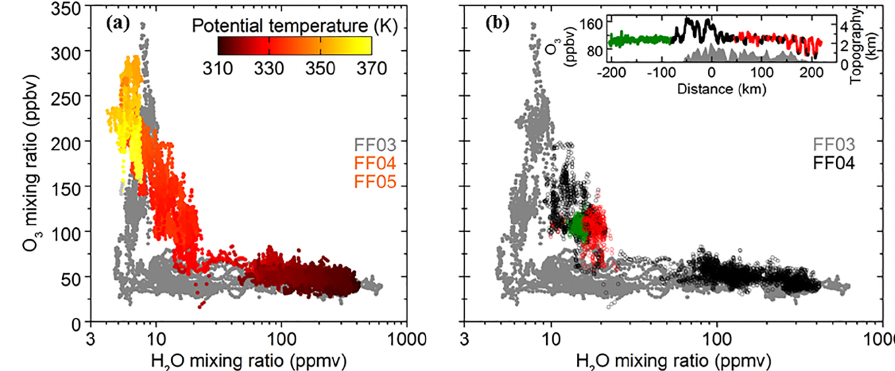
Figure 8. H 2 O–O 3 correlation for three Falcon flights: (a) FF04 and FF05 in mountain wave conditions and FF03 in unperturbed conditions. Potential temperature is color-coded for FF04 and FF05. (b) FF04 with a red-marked region for potential temperatures between 329 and 334K that correspond to regions where turbulence in the dropsonde data of flight RF16 was observed. The inlay in (b) gives the ozone mixing ratio of flight FF04 leg 3 at 10.8km. The red data points show the localization of potential temperatures between 329 and 334K in the ozone data and green data points mark the upstream region of this flight